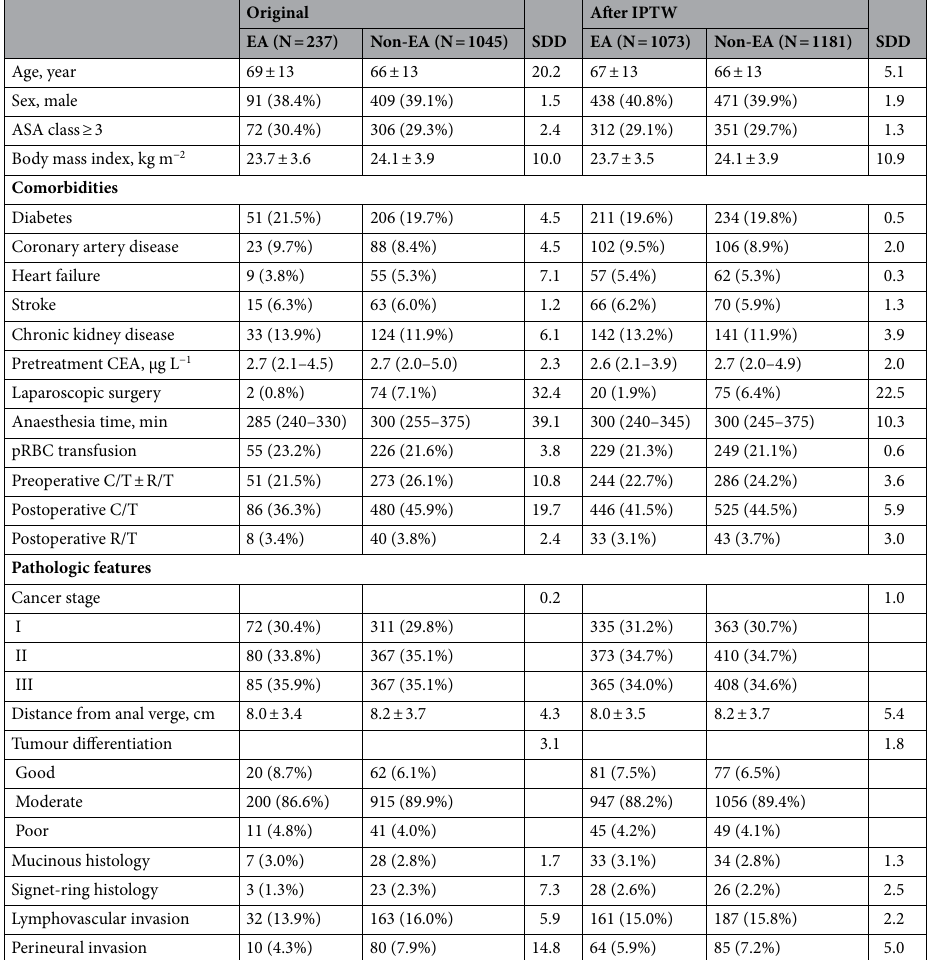
Table 1. Demographic, clinical, and pathologic characteristics of included patients before and after IPTW. Values were mean ± SD, counts (percent), or median (interquartile range). SDD standardised difference, ASA American Society of Anesthesiologists, CEA carcinoembryonic antigen, C/T chemotherapy, EA epidural analgesia, IPTW inverse probability of treatment weighting, pRBC packed red blood cells, R/T radiotherapy.